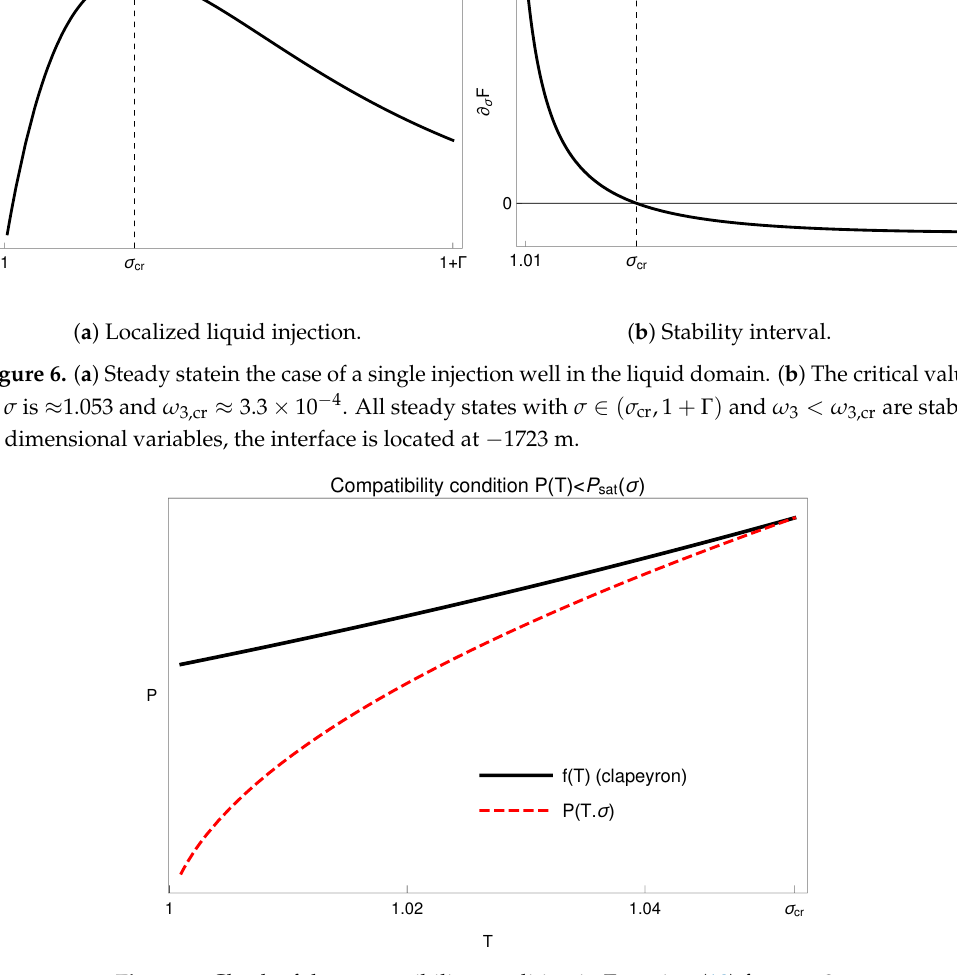
Figure 7. Check of the compatibility condition in Equation (18) for case